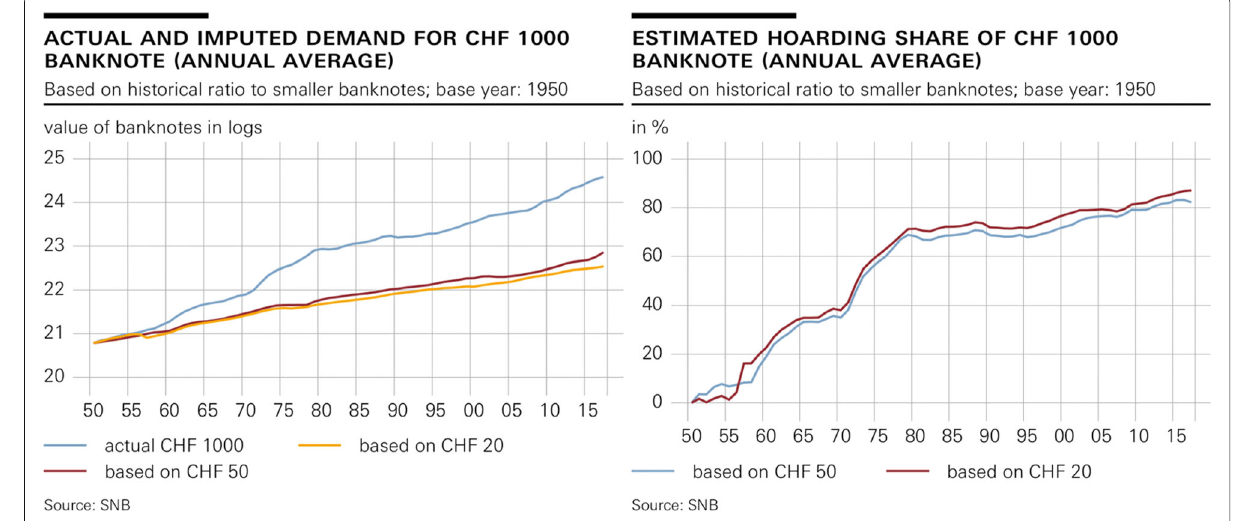
Fig. 2 Method based on ratios – results for CHF 1000 banknote